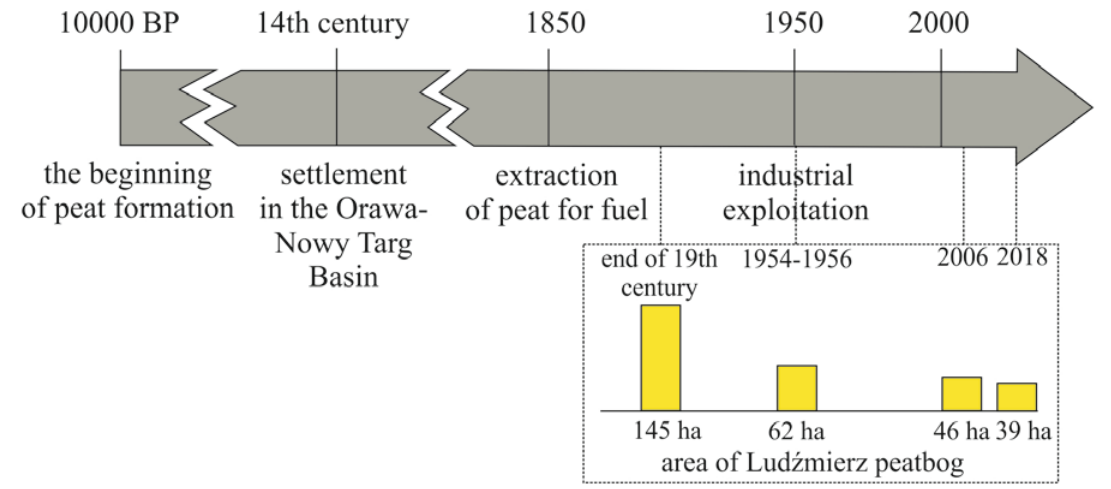
Figure 1. Key stages of peat-forming processes and anthropogenic changes in peatlands of the Orawa- Nowotarska Basin (Lubicz- Niezabitowski 1922, Jostowa 1963, Obidowicz 1988, Łajczak